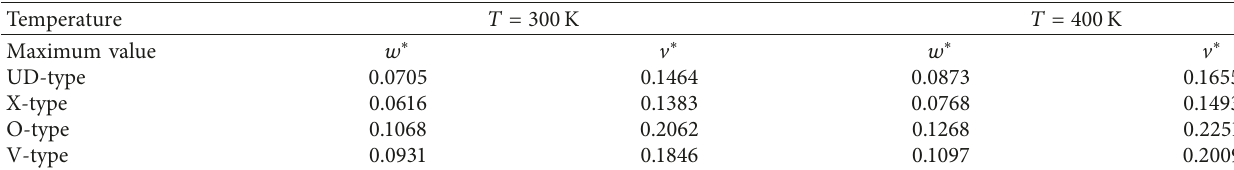
400K: (a) deflection w ; (b) velocity v ; (c) stress σ x ; (cid:31) ∗ ∗ 300 K T 400K (cid:31) (cid:31) v ∗